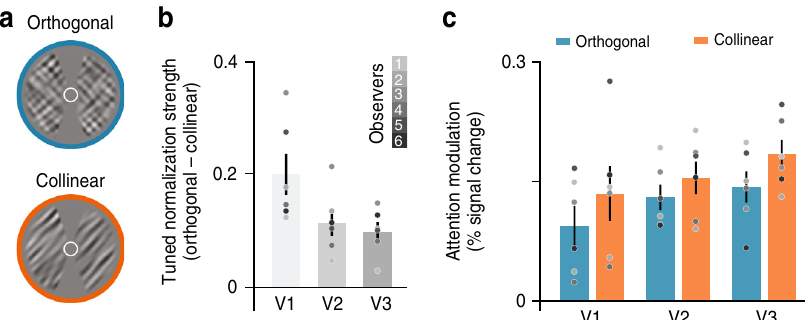
Fig. 5 Tuned normalization modulates spatial attention. a Stimuli were comprised of orientation bandpass- fi ltered noise gratings (outer diameter 15°; inner diameter 3°; spared midline; individual component was rendered at 25% Michelson contrast, resulting in a combined grating of 50% Michelson contrast), comparable to stimuli used for Experiment 1. Participants performed a demanding spatial attention task, detecting and discriminating a small gray Gaussian disk embedded in either the upper or lower visual fi eld of the attended location (a cue presented throughout the block at fi xation informed the participant to attend the left or right side of fi xation). b Tuned normalization strength represents the difference between BOLD responses evoked by orthogonal and collinear stimuli blocks when attention was directed away (% signal change). The orthogonal con fi guration elicited larger BOLD responses compared with the collinear con fi guration across V1 – V3. c Attention modulation re fl ects the difference between BOLD responses when spatial attention was either directed toward or away from the stimuli locations, for both collinear and orthogonal con fi gurations. Error bars denote ± 1 S.E.M., N = 6, gray dots illustrate different participants; stimuli are modi fi ed for illustrative (individual components 25% contrast, resulting in a combined